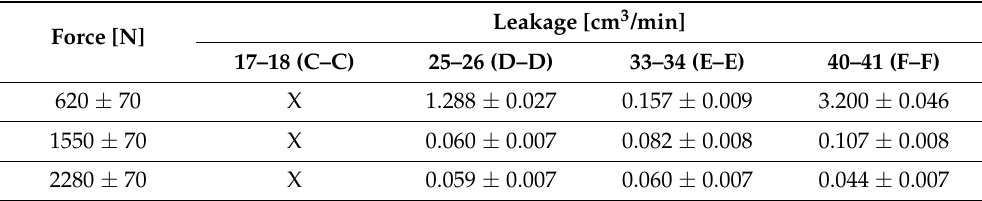
Table 7. Forces and leakage of sets with matching surface topography parameters from code groups C, D, E, and F.